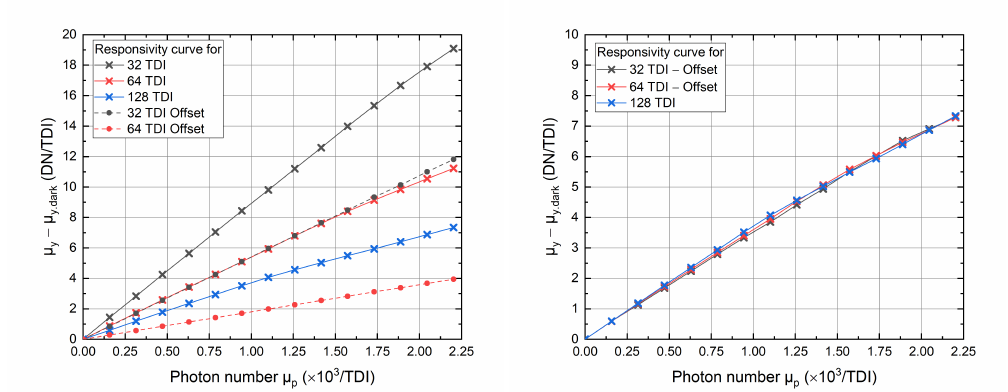
Figure 7. Responsivity curves measured without integration of the anti-blooming clocking for different numbers of TDI stages. Dotted curves in the figure on the left show the light-dependent offset for 32 and 64 TDI stages. The plot on the right shows responsivity curves after the offset has been